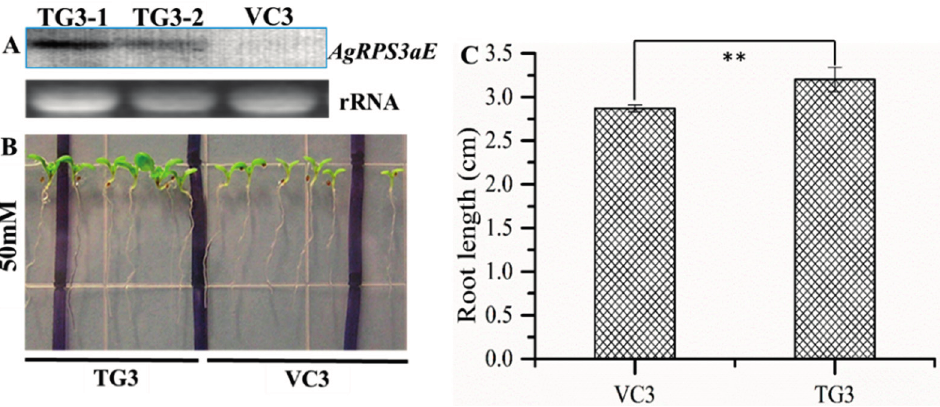
Figure 6. Effect of AgRPS3aE overexpression on salt tolerance in transgenic Arabidopsis . ( A ) Northern blotting analysis of three independent T3 generation transgenic